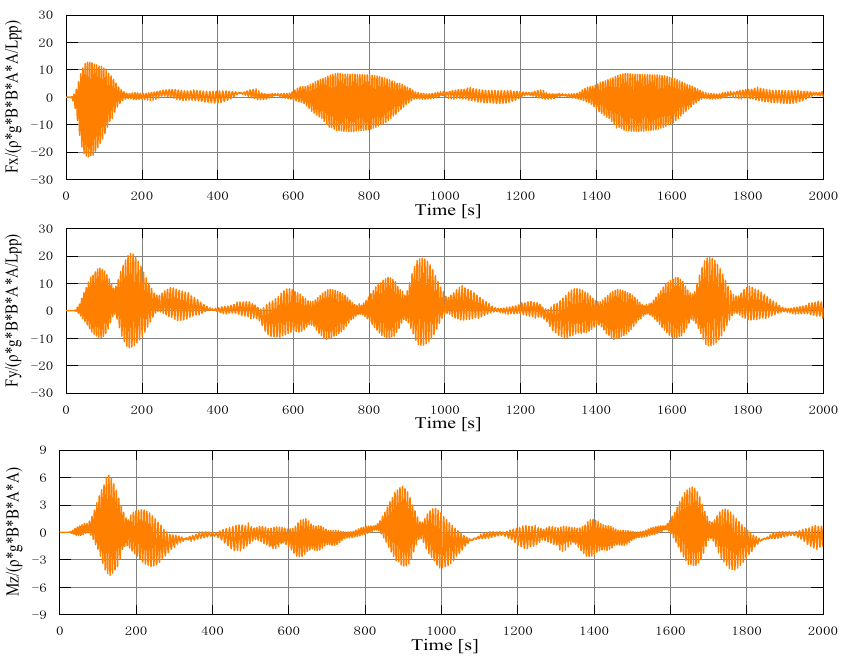
Figure 22. Surge, sway, and yaw wave drift forces and moment of the KVLCC2 under +35° turns.